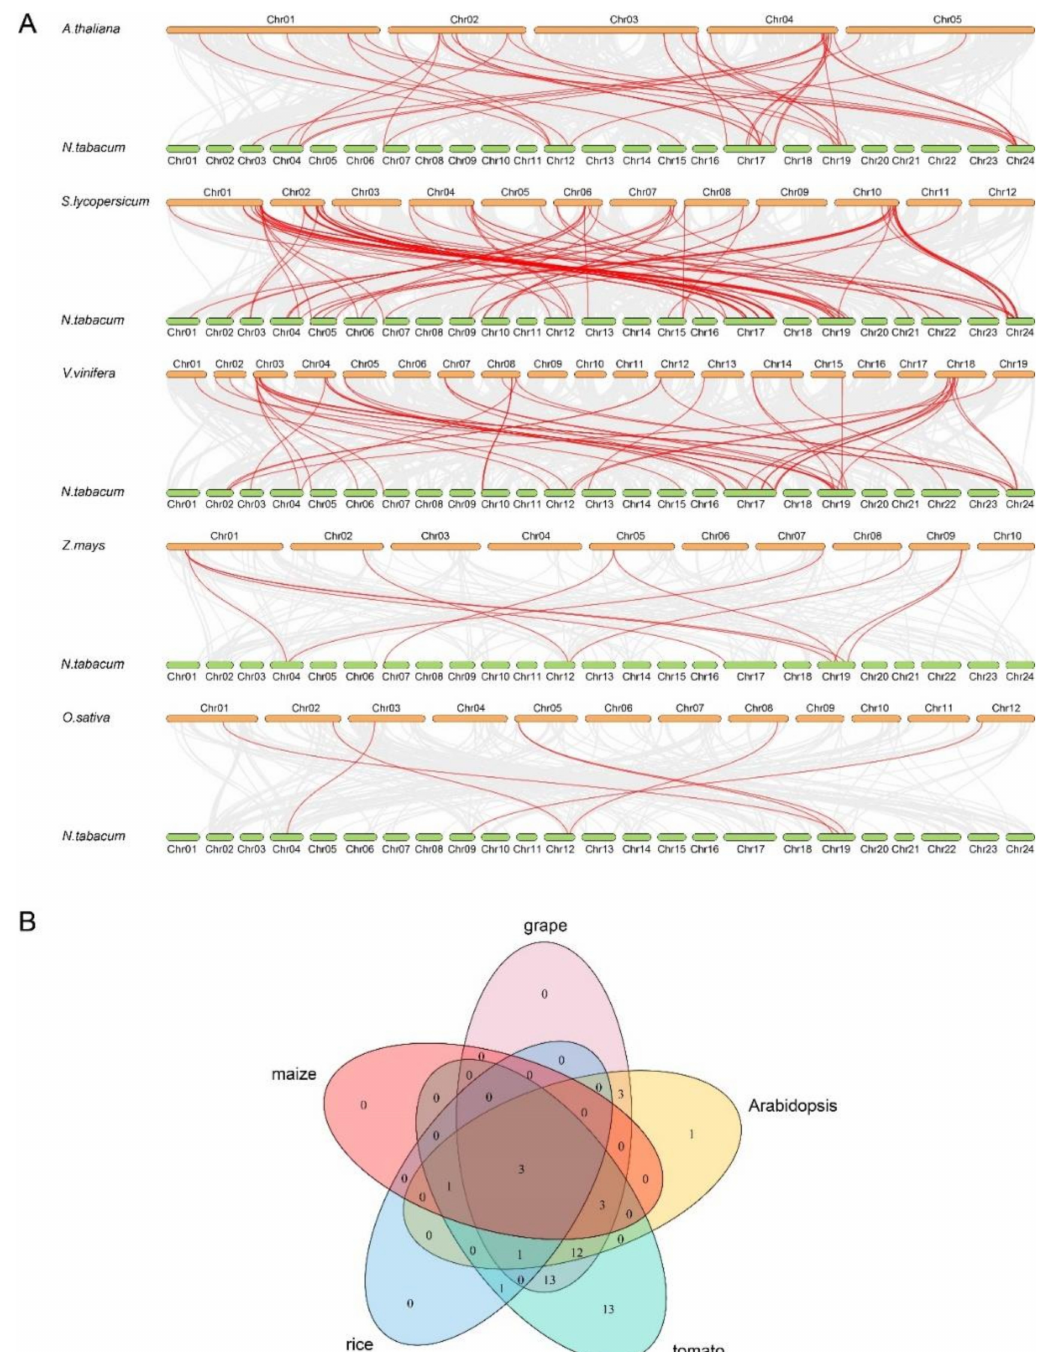
Figure 2. Syntenic relationship analysis between bZIP genes in tobacco and bZIP genes in five other species. ( A ) The collinear pairs between tobacco and five other species are represented by the gray line, while the collinear bZIP gene pairs are highlighted by the red color. ( B ) The bZIP genes formed the syntenic pairs between tobacco and all the other five selected species, visualized by